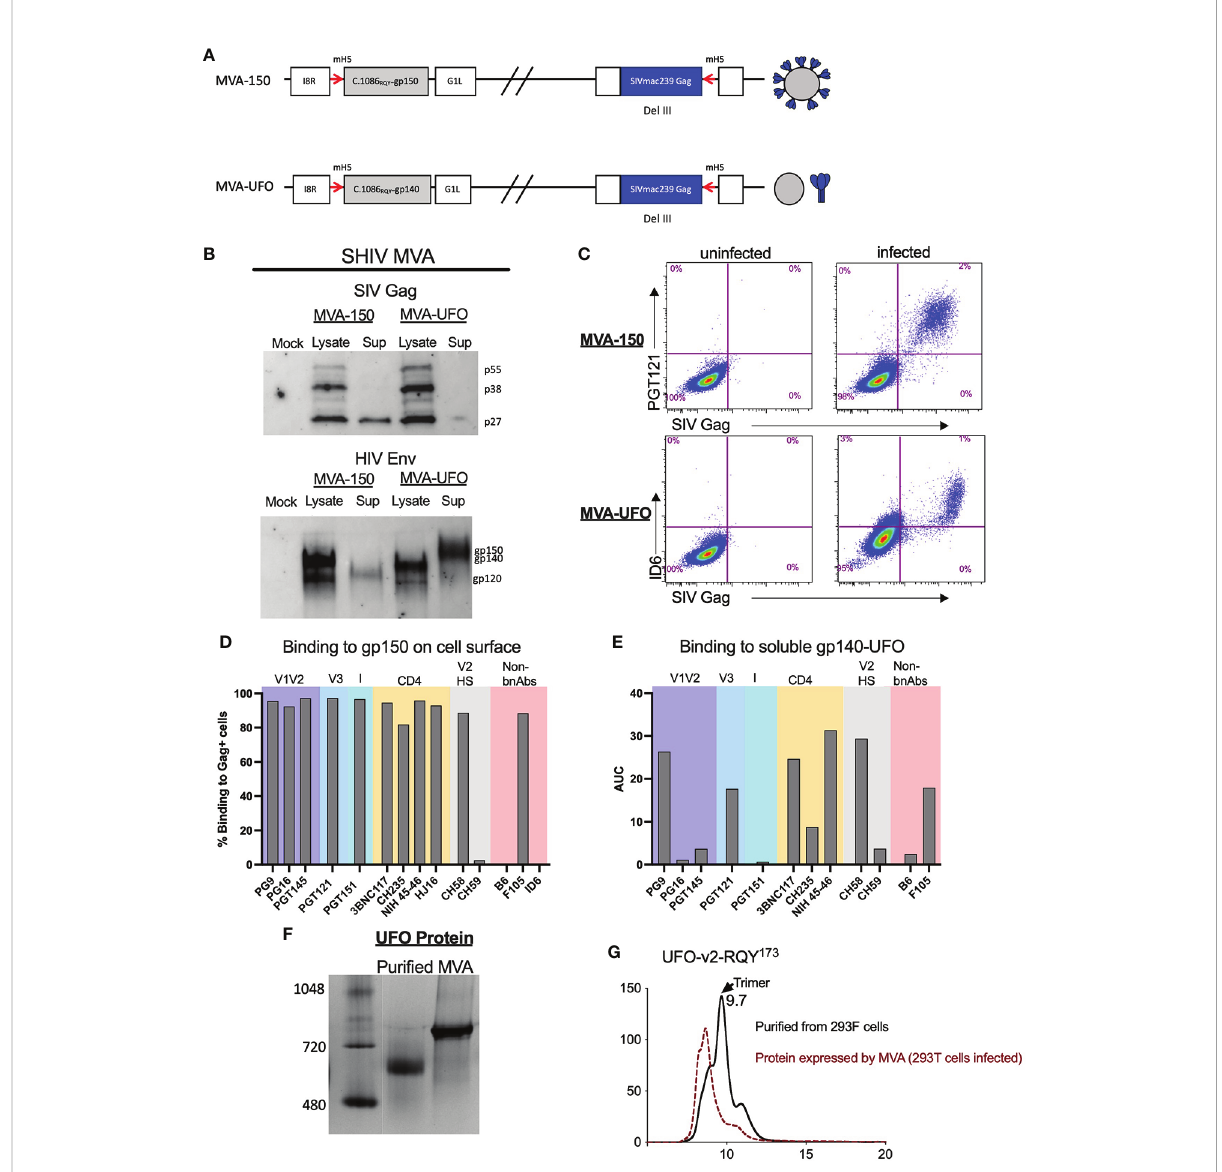
FIGURE 2 Characterization of SHIV MVA-150 and MVA-UFO. (A) Schematic of SHIV MVA gp150 and gp140 constructs. (B) Western blot analysis of SIV Gag and HIV C.1086 Env in the lysate and supernatant of infected cells. (C) Flow cytometry of DF-1 infected cells depicting the surface co- expression of HIV Env on SIV Gag positive cells. (D) Surface binding of bNAbs and non-bNAbs to SIV Gag positive MVA infected cells. (E) bNAbs and non-bNAbs binding to secreted C.1086 gp140 UFO protein via ConA ELISA. (F) Western blot analysis of puri fi ed gp140 C.1086 UFO protein and MVA secreted gp140 C.1086 UFO protein. (G) SEC pro fi le of puri fi ed and MVA secreted C.1086 UFO